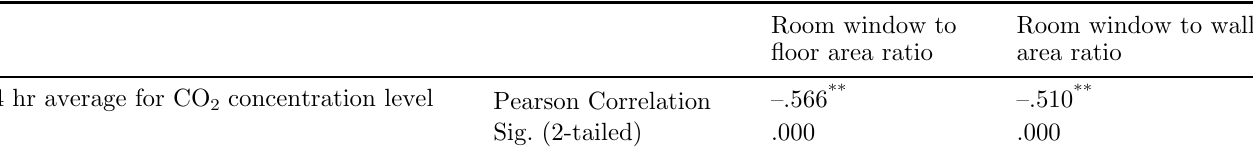
Fig. 1. CO 2 concentration values in the different spatial design Fig. 2. CO 2 concentration values in the different spatial design layouts during dry season. layouts during wet season. Table 4. Relationship between CO concentration levels and aspects of room physical 2